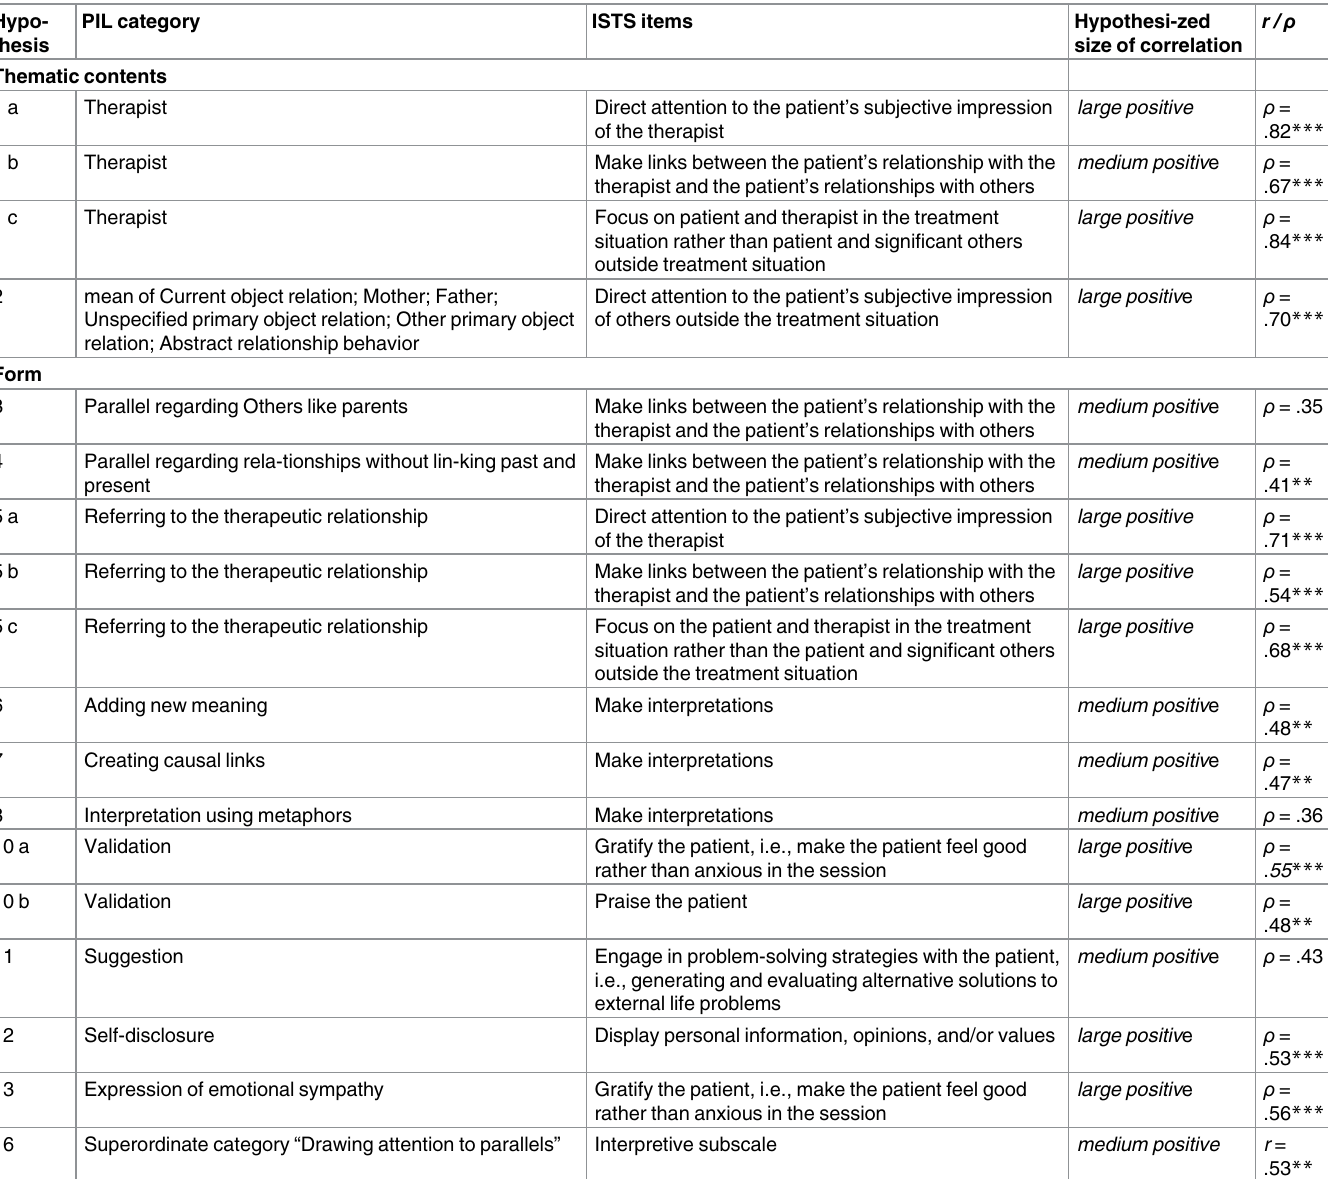
Table 3. Hypotheses and results for the correlations between the PIL categories and ISTS items. Hypo- PIL thesis